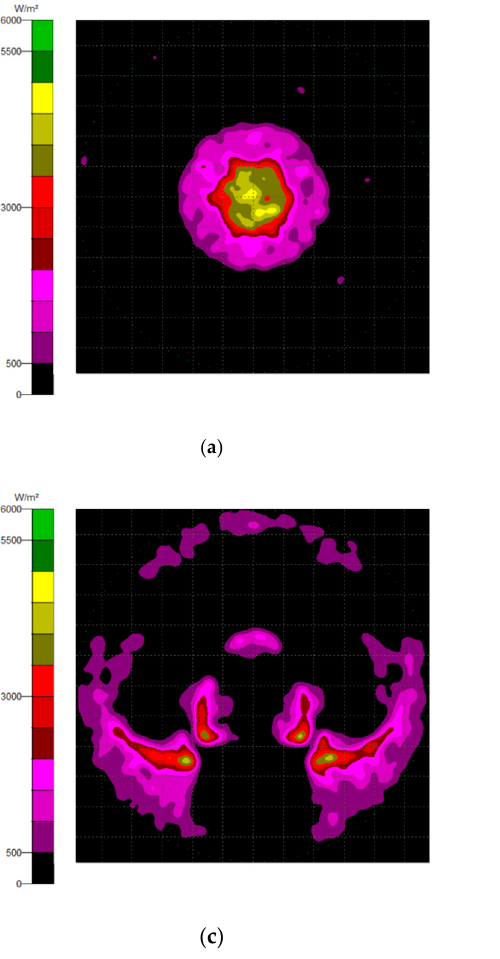
Figure 20. The irradiance distribution of the mirror-NACPC and the TIR collimator with misalignment angles of ( a ) 0 ◦ , ( b ) 10 ◦ , ( c ) 20 ◦ , and ( d ) 30 ◦ .